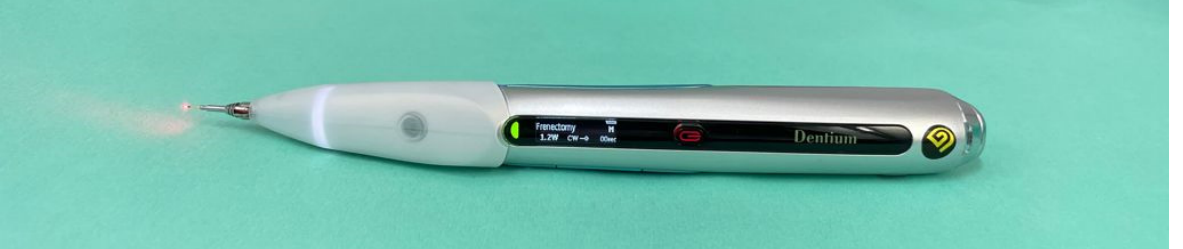
Figure 7. Laser settings.